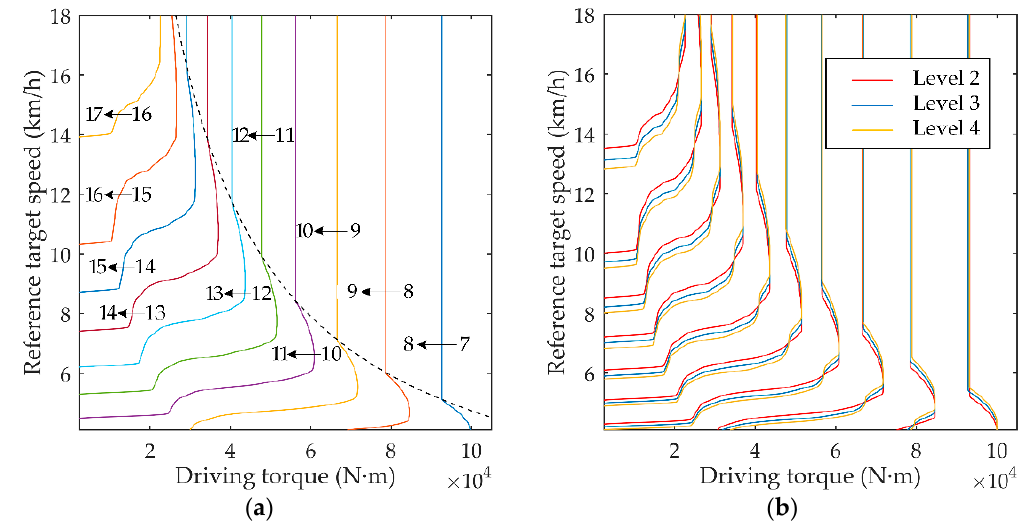
Figure 9. The up gear-shift maps. ( a ) Mode of level 1; ( b ) Modes of level 2–4.